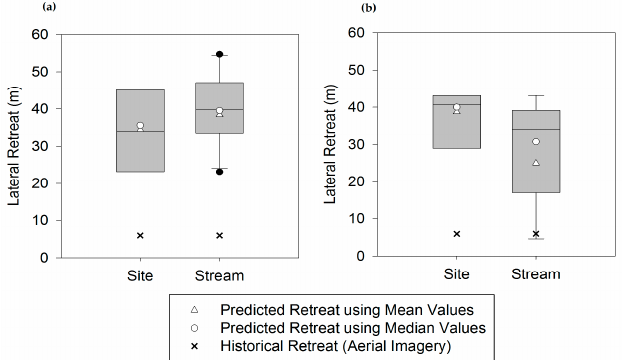
Figure 8. Boxplots of variation in CONCEPTS predicted lateral retreat at a site on Fivemile Creek using JET results from the site and entire stream reach for: ( a ) excess shear stress model; and ( b ) Wilson model.